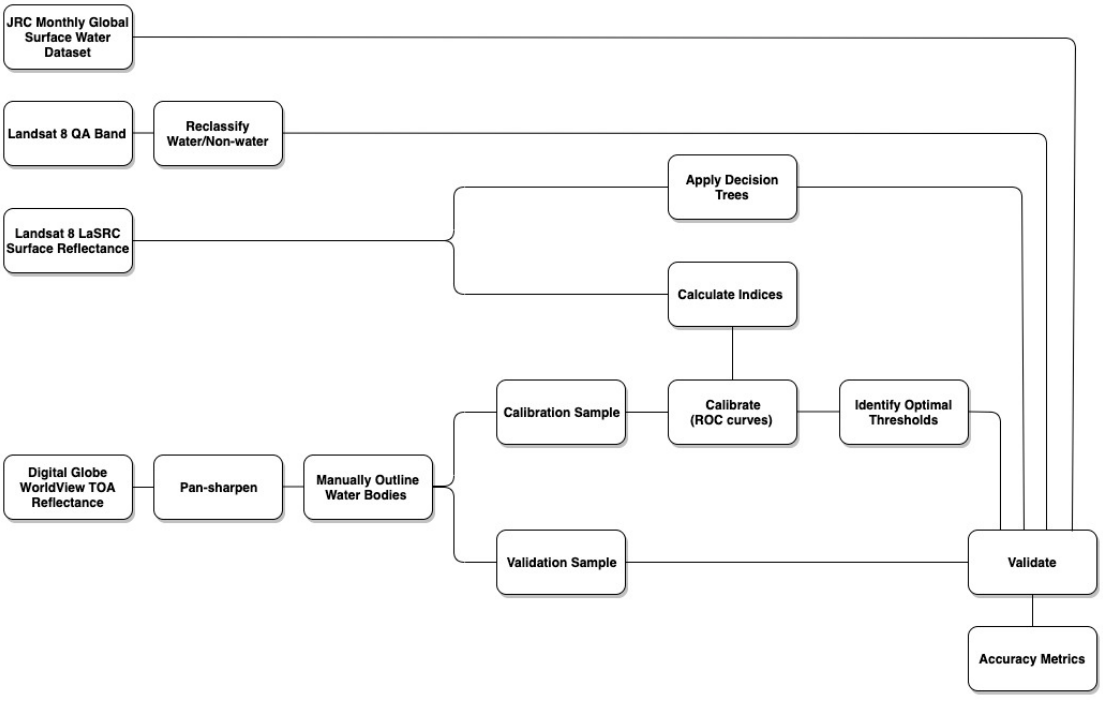
Figure 3. Flowchart of methods. Input datasets include the Joint Research Center (JRC) monthly global surface water dataset, Landsat 8 surface reflectance and QA band, and DigitalGlobe WorldView imagery.